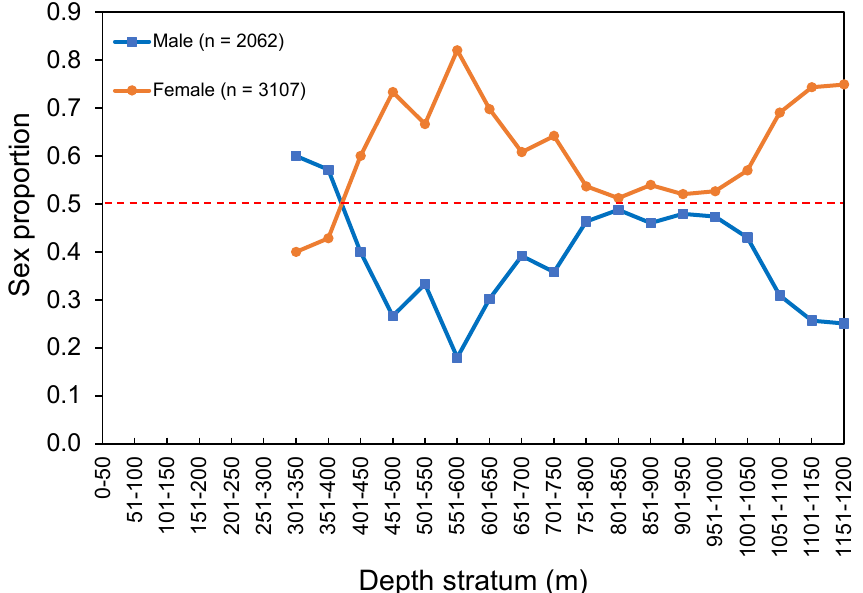
Figure 6. Sex proportion of Mora moro by depth stratum derived from the surveys (1996–2019) in the Azores. The total number of individuals (n) refers to the total RPN (ind. 10 − 3 hooks). Red dashed line shows an equal sex ratio.